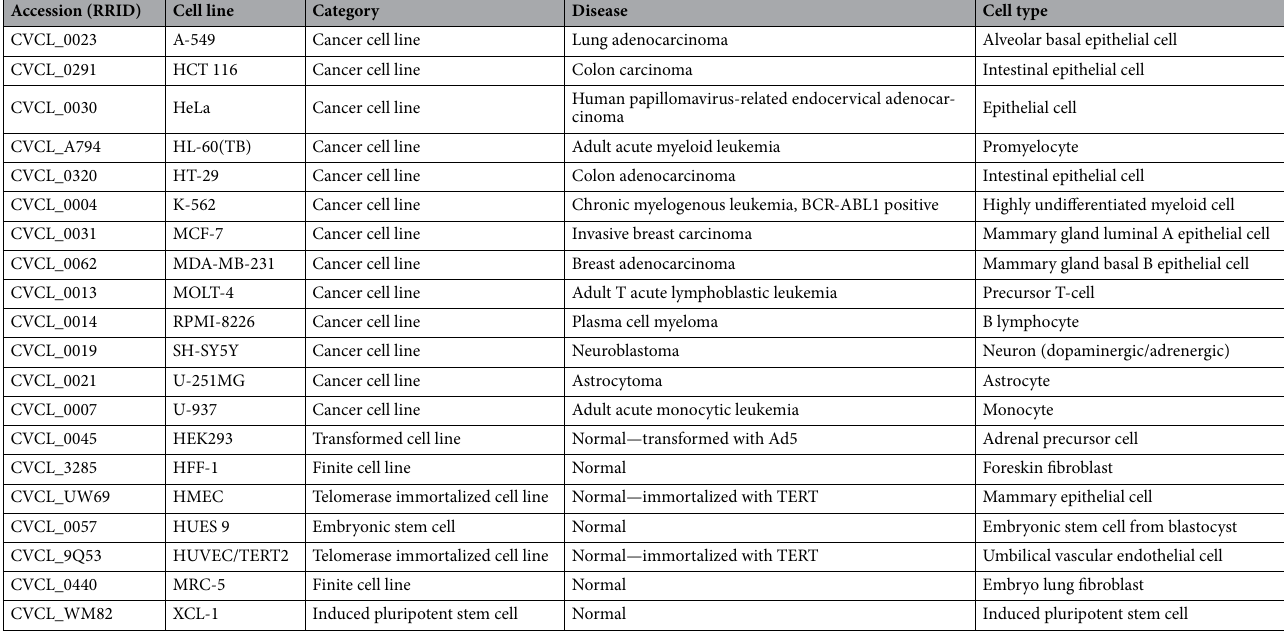
Table 1. Cell lines used in this